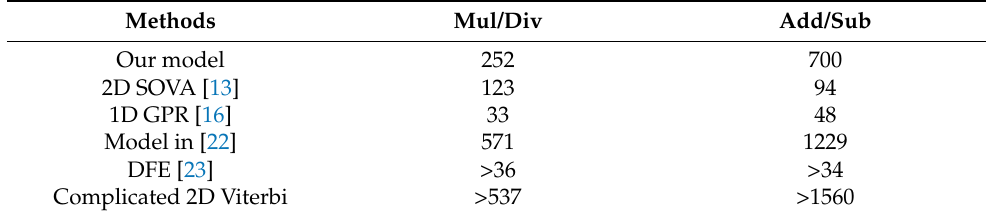
Table 3. The complexity of the proposed and other